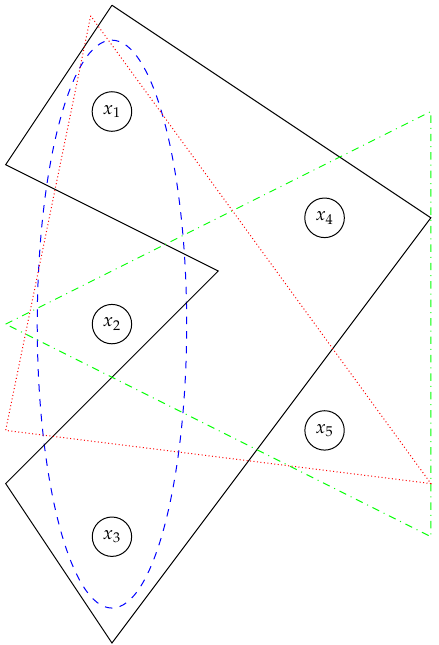
Figure 5. The derived graph for the product formulation of Example 1. There are four hyperedges: x 1 x 2 x 3 in dashed blue, x 1 x 3 x 4 in black, x 2 x 4 x 5 in dashdotted green, and x 1 x 2 x 5 in densely dotted red. The chromatic index of the graph is four and the unitary circuit depth is